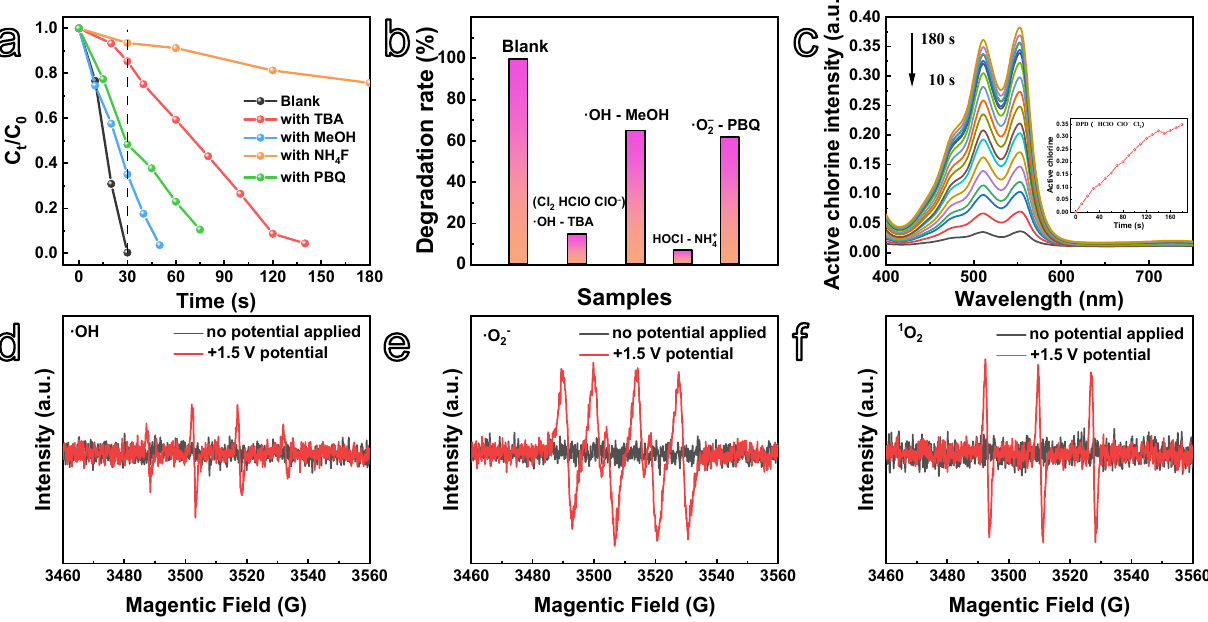
Figure 6. ( a ) Relative concentration of RhB versus time after the addition of scavenger. ( b ) The effect of scavengers on the degradability of np-Ni@NiO-4. ( c ) The absorbance curve of the NaCl solutions under different times with the addition of DPD (the inset shows the peak intensity at λ = 515 nm curve versus time). The EPR spectra of ( d ) · OH; ( e ) · O 2 − ; and ( f ) 1 O 2 generated under different conditions for the